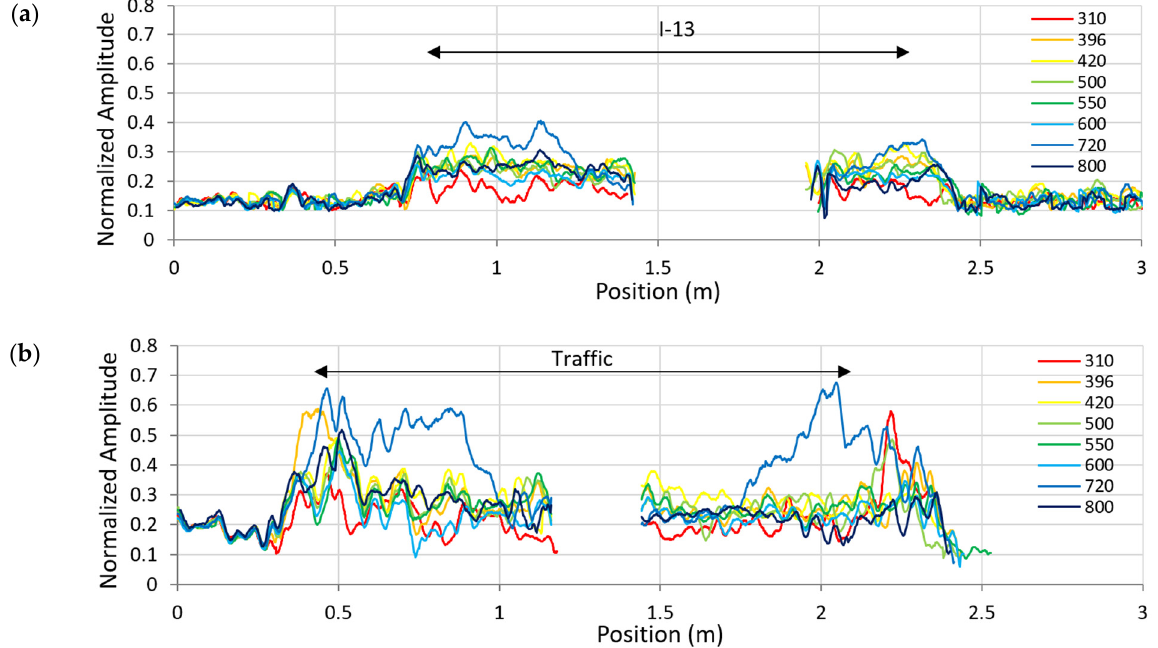
Figure 14. 2.6 GHz Norm. RW amplitudes on tack-coat free (I-13) in the ( a ) long. and ( b ) transv. direction vs. K loadings.